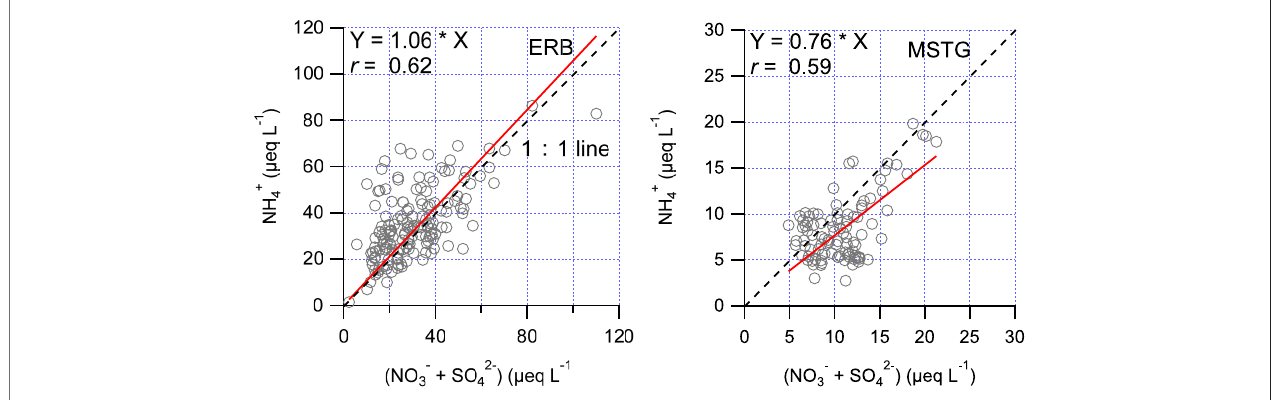
FIGURE 6 | Scatter plots with best- fi tting linear regression between NH 4+ and (NO 3 − + SO 42- ) in equivalent concentration (µeq L − 1 ) for ERB and MSTG. The fi tting equation and Pearson ’ s correlation coef fi cient are also shown. The dashed line represents the 1:1 line.